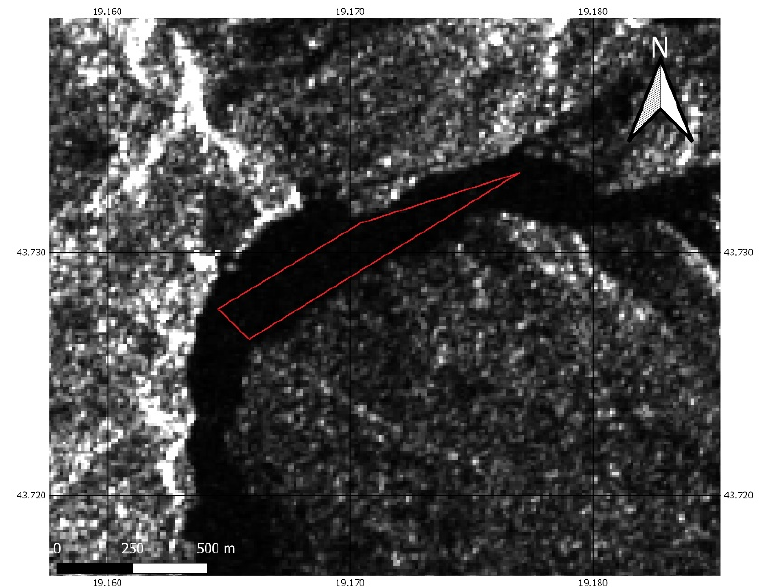
Figure 9. Mask of Clean region within River Drina, Bosnia & Herzegovina, 4 June 2020. The red polygon highlights the region used for the clean mask (Sentinel-1, Credits: ESA).